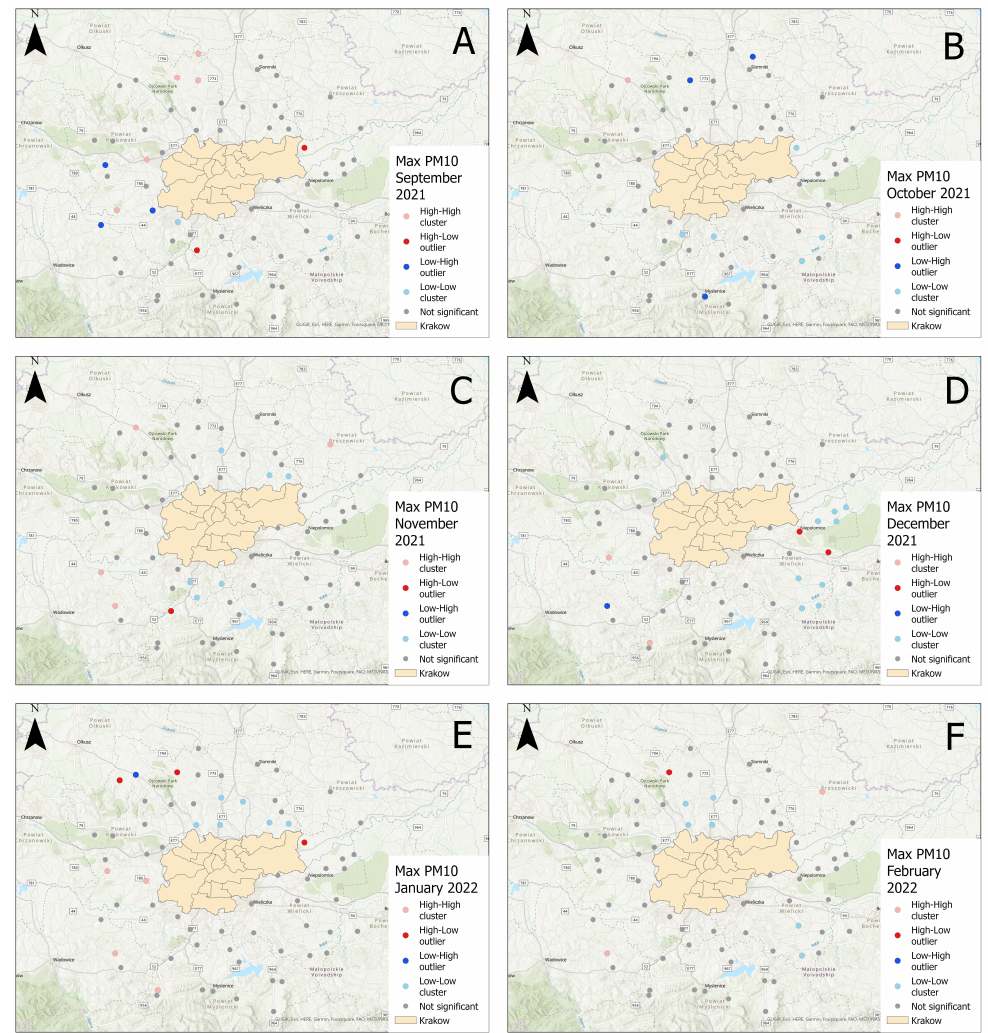
Figure 12. The spatial associations for monthly maximum PM10 concentrations showing high- high and low-low clusters and high-low and low-high outliers using Local Moran’s I. The maps illustrate clustering in September ( A ), October ( B ), November ( C ), December 2021 ( D ), January ( E ), and February 2022 ( F